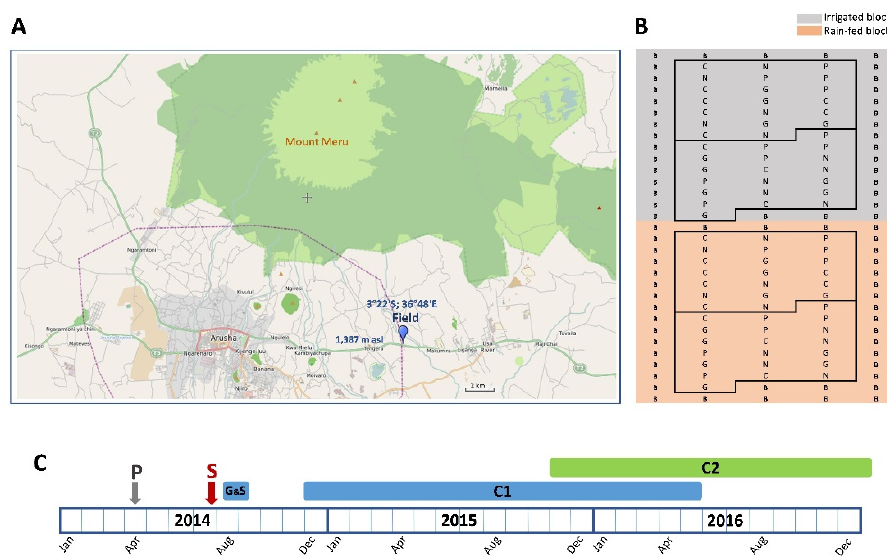
Figure 1. Site, layout and timeline of the experiment. ( A ) Map with the